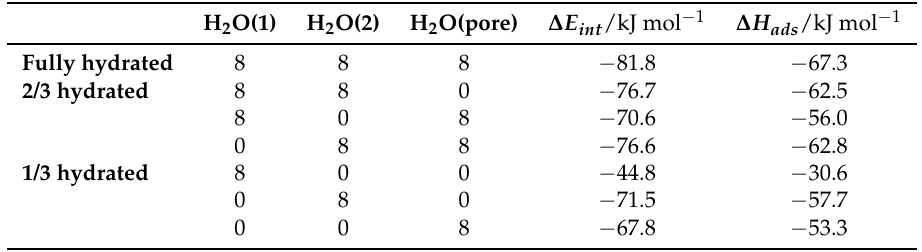
Table 3. Calculated interaction energies and adsorption enthalpies for fully hydrated AlPO 4 -H3 and derived partially hydrated phases. All values are given per H 2 O